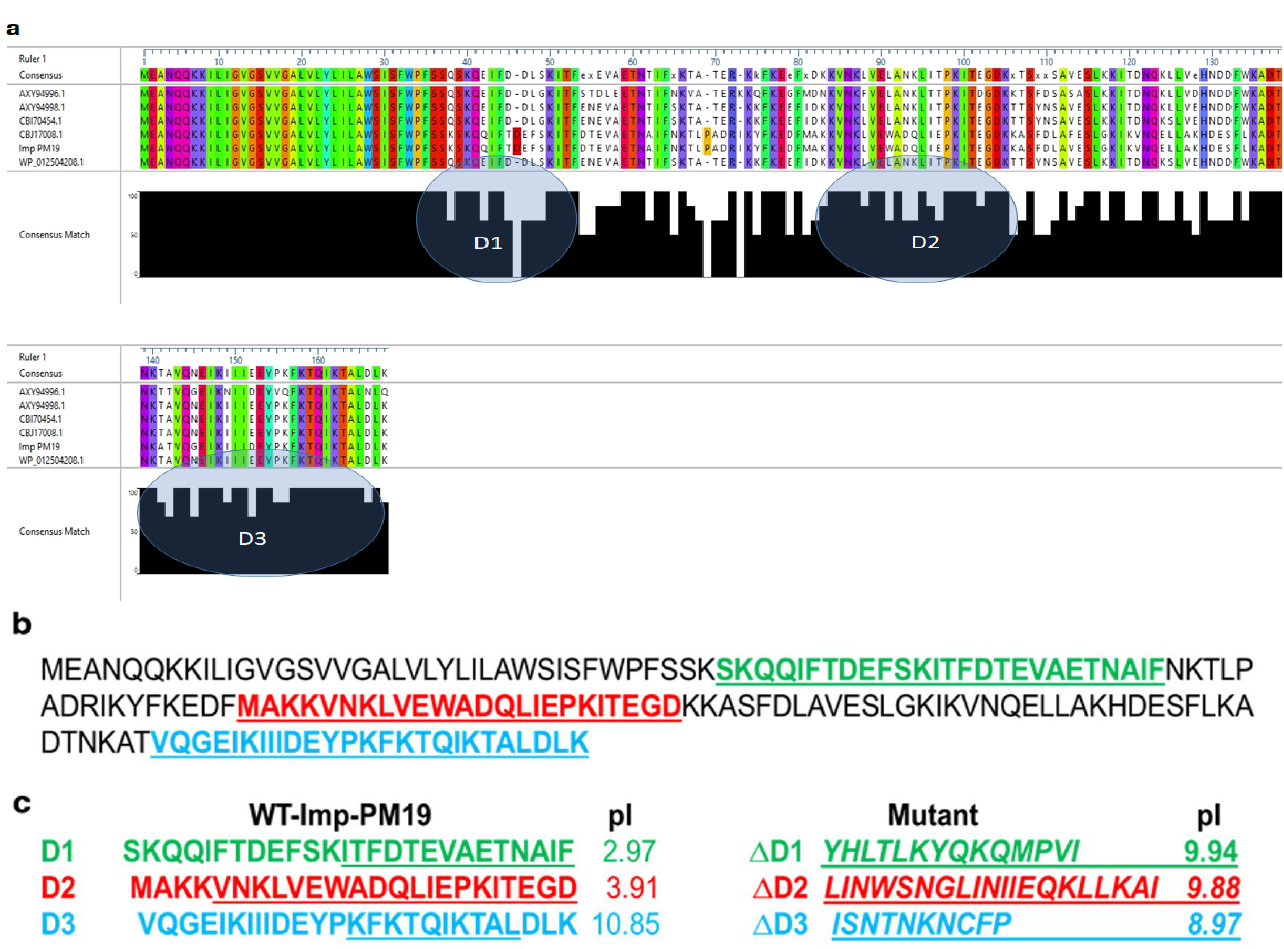
Figure 1. Amino acid sequence alignment of Imp-PM19 of different ‘ Ca . P. mali’strains. ( a ) Amino acid sequences of Imp obtained from Gene Bank were aligned using DNA star program. Color letter indicate conserved amino acids. The grey shaded area (circled) in consensus math indicates the conserved regions. ( b ) Protein sequence of Imp-PM19 and ( c ) mutants. Green, Red and Blue labeled are D1-D3 conserved regions and their pI which were mutated (underlined letters) to generate ΔD1 - ∆D3 -Imp-PM19 -mutants (italic and underlined letters), respectively.